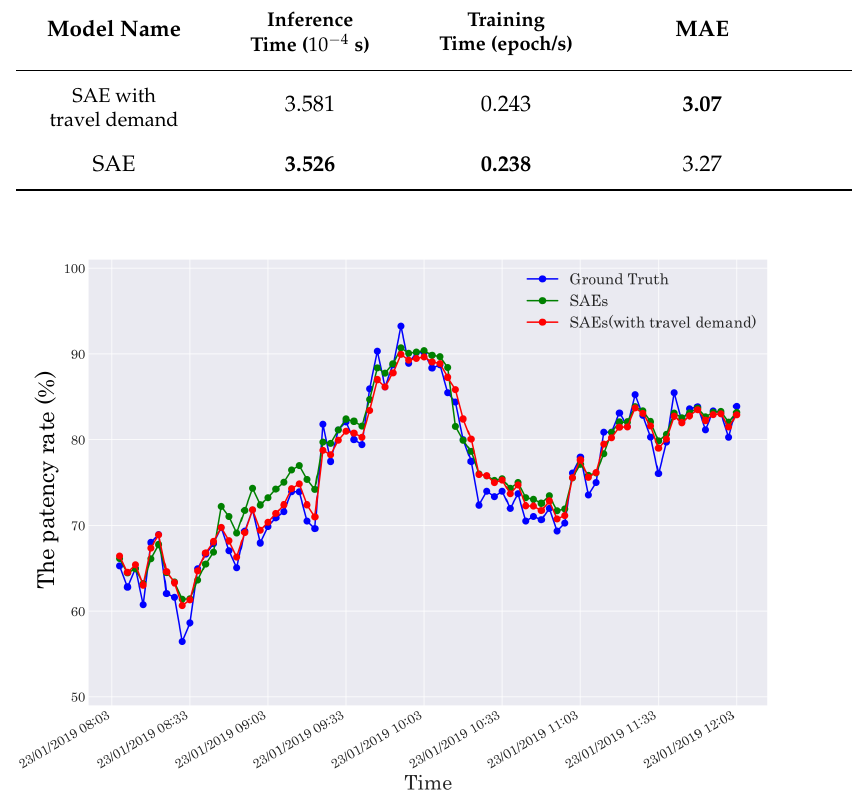
Figure 9. The comparison between SAE model with and without travel demand obtained from cellular